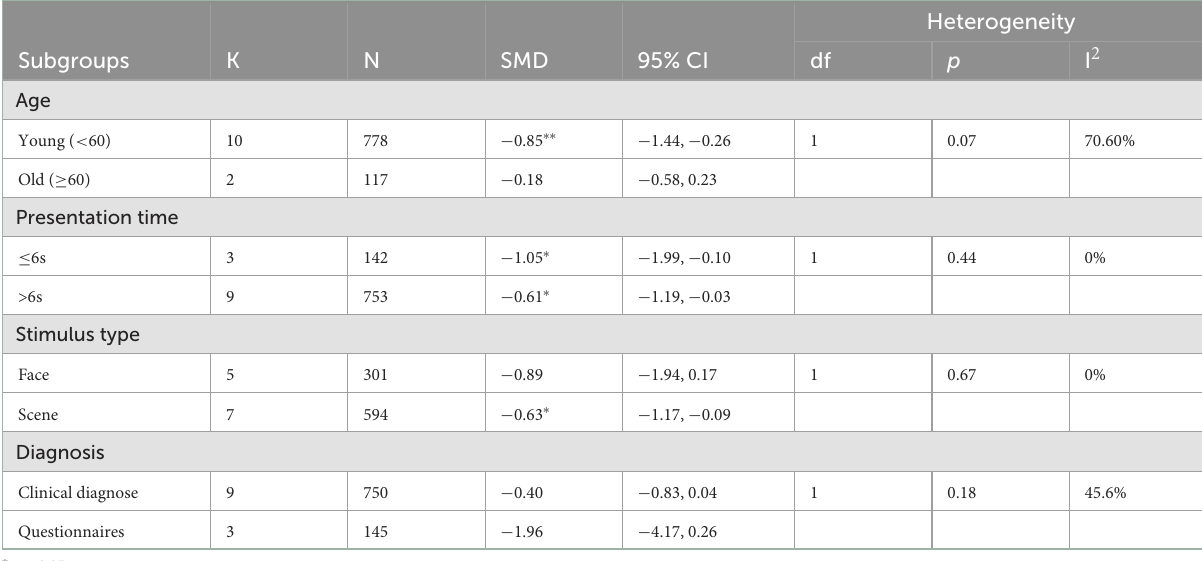
TABLE 5 Moderate effect of fixation duration under positive emotional